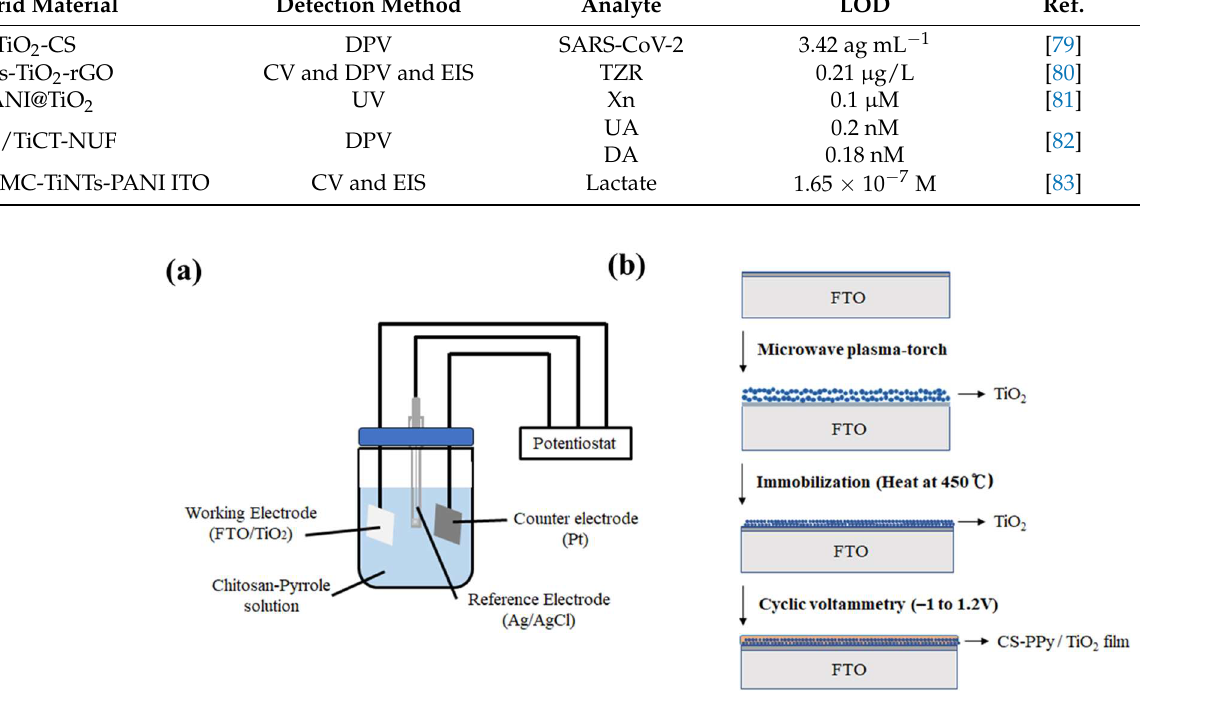
Figure 7. Schematic diagram of ( a ) a three-electrode measuring system and ( b ) the preparing CS- Py/TiO 2 nanocomposite films on FTO (Reprinted with permission from Ref. [79]. Copyright 2021, Py/TiO 2 nanocomposite films on FTO (Reprinted with permission from Ref. [78]. Copyright 2021, Biosensors (Basel)). Biosensors